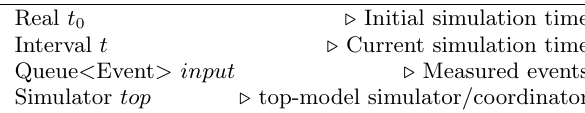
Algorithm 2 Abstract Root-Coordinator main-loop